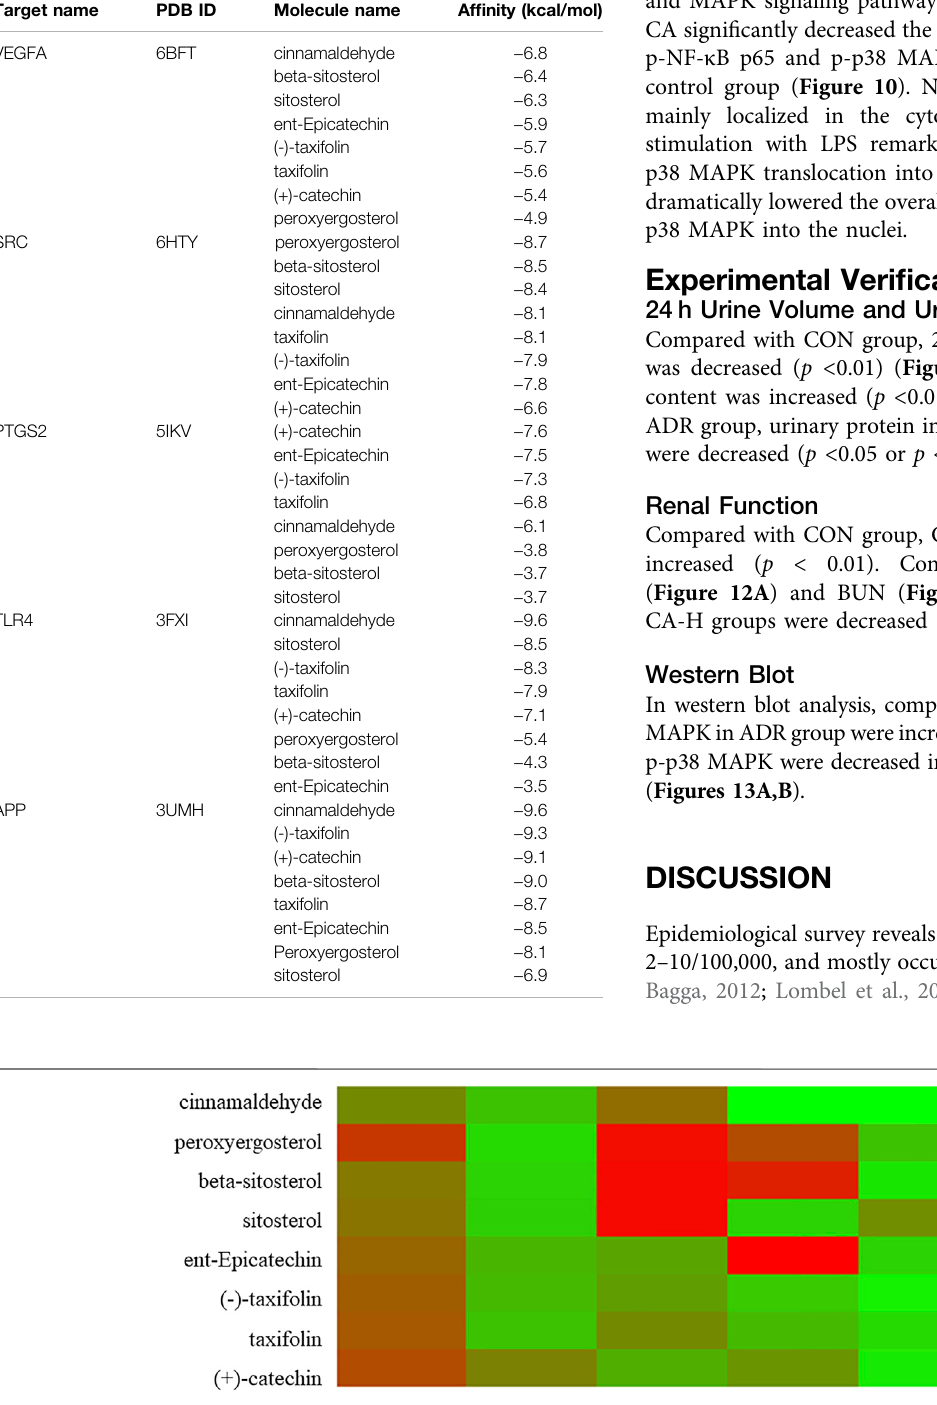
TABLE 5 | Molecular docking results of targets and active components.